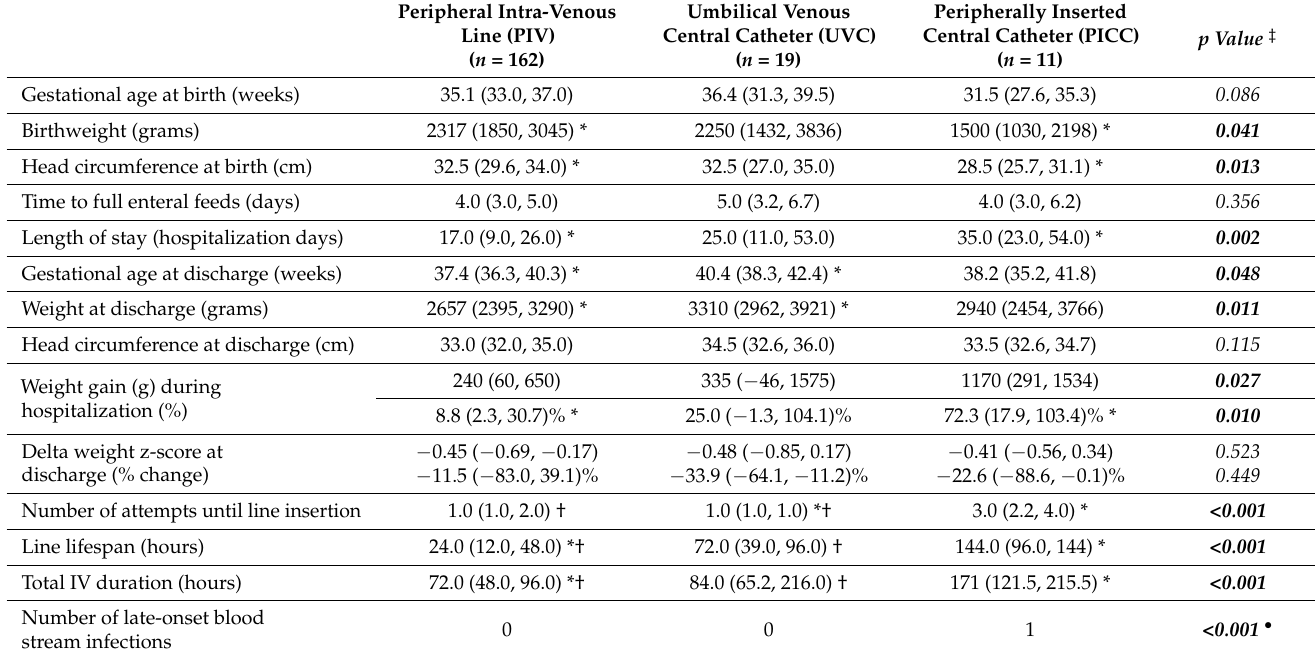
Table 2. Analysis of clinical characteristics and outcomes by the type of IV lines used ( n = 192): This analysis includes all instances of venous access.